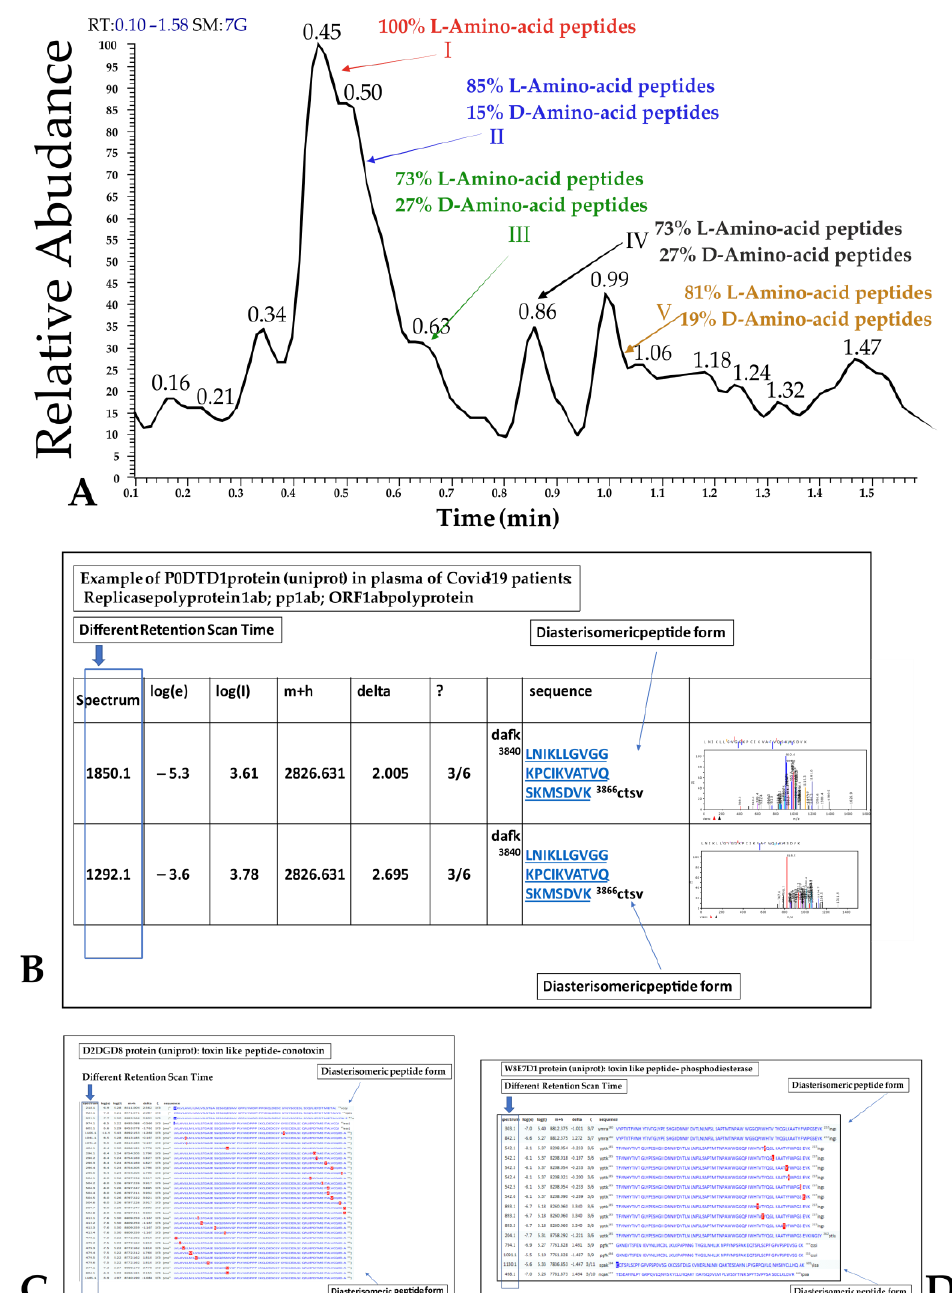
Figure 4. Representative image of diastereomeric peptides containing D-Amino acid in SARS-CoV-2 proteins and in toxin-like peptides in blood samples of infected individuals. Panel A : SACI-CIMS scan of voltages. Selective retention time ion cutting was employed; Panel B : Example of P0DTD1 protein (UniProt) in plasma of COVID-19 individuals. Replicase polyprotein 1ab; pp1ab; ORF1ab polyprotein. The rectangles show different retention scan times, suggestive of different D-Amino acids presence. Images of the spectra on the right side of panel B are highlighted at higher resolution in Figure S3 of supplementary materials. Panel C : different retention scan times of toxin-like peptides, D2DGD8 protein (UniProt): toxin-like peptides conotoxin. Panel D : different retention scan times of toxin-like peptide W8E7D1 protein (UniProt): toxin-like peptides